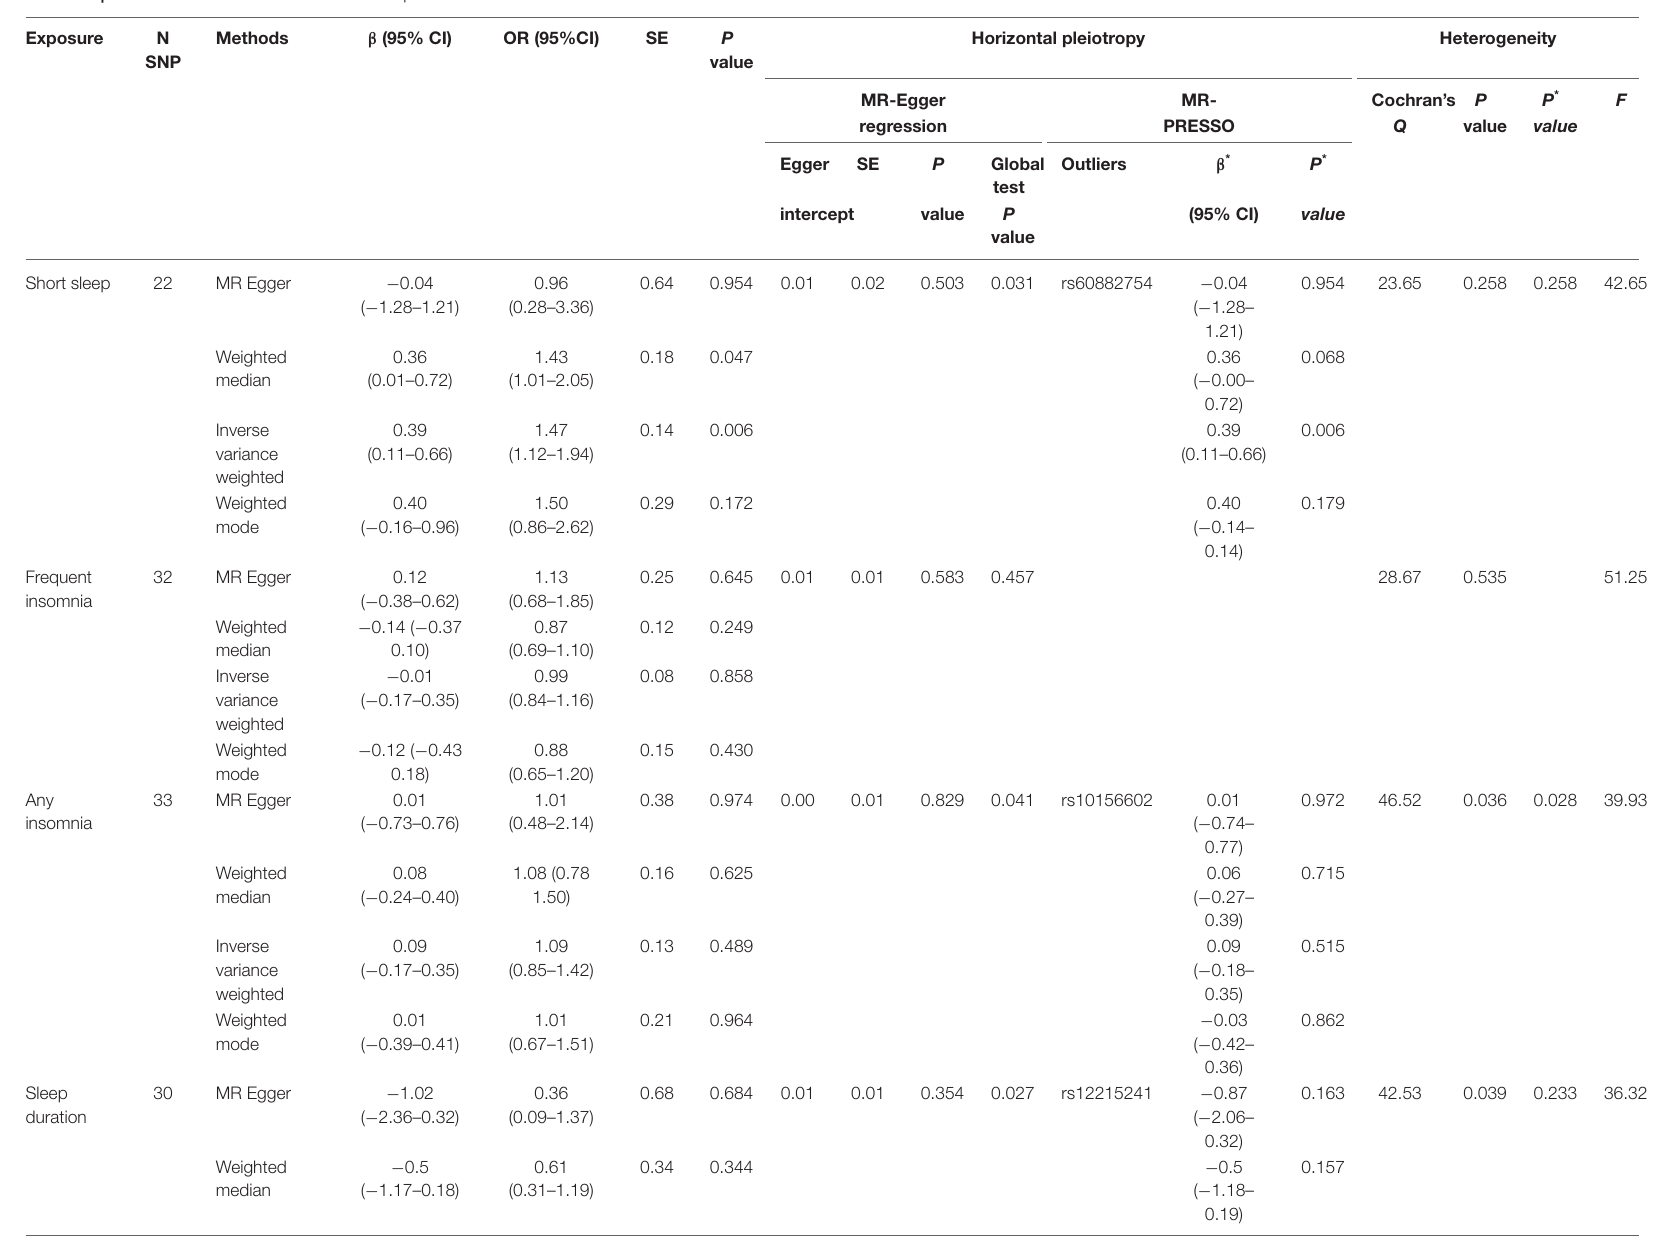
TABLE 1 | MR results of causal links between sleep traits and RA risk.